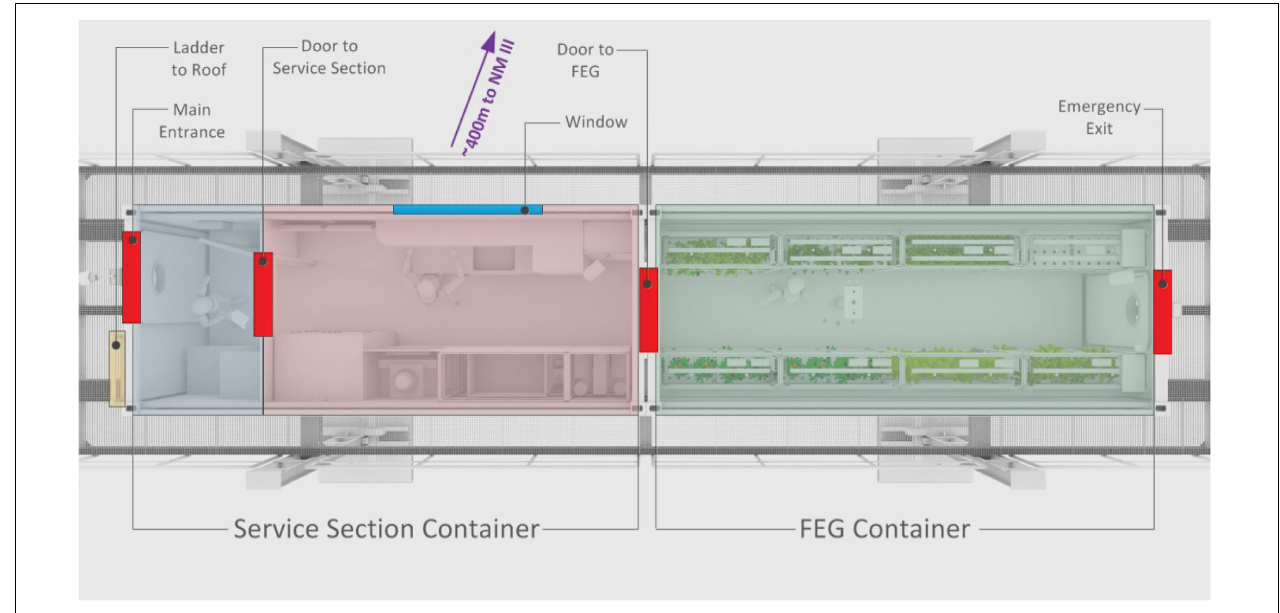
FIGURE 2 | Schematic top-view of the MTF. The blue section indicates the cold porch. The red area is called service section and houses a work desk and almost all greenhouse subsystems. The green section is the main plant cultivation space, called the